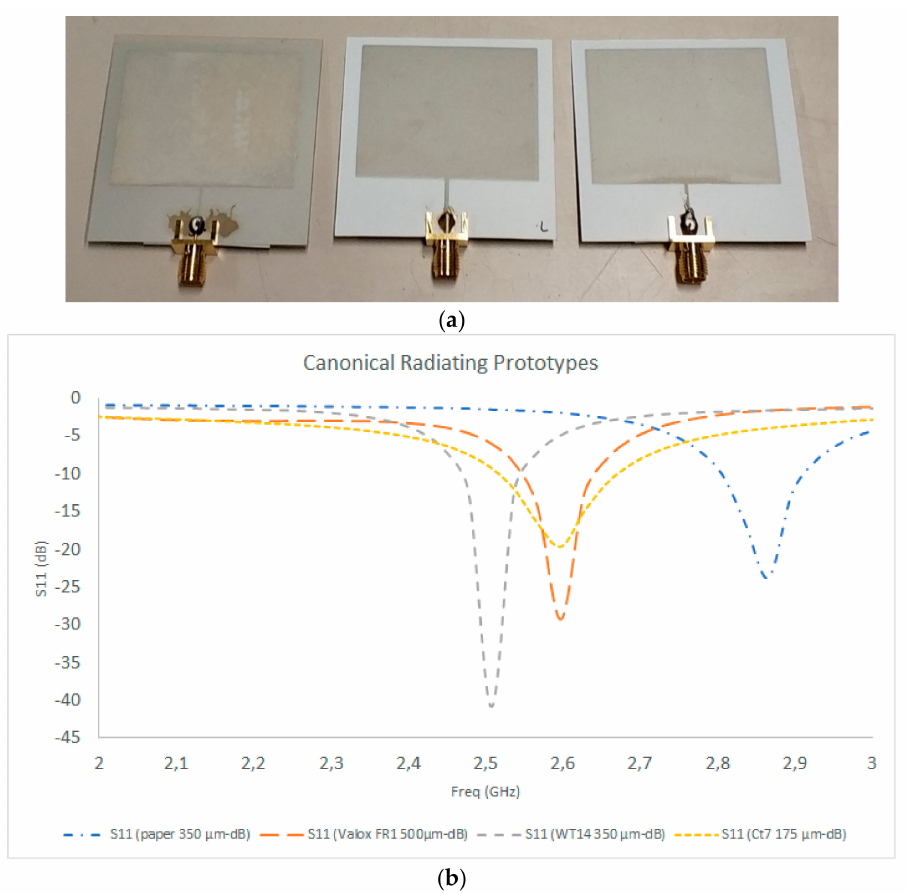
Figure 5. ( a ) Fabricated prototypes for radiating elements; ( b ): S11 parameter measurement results for di ff erent substrates (plastic /